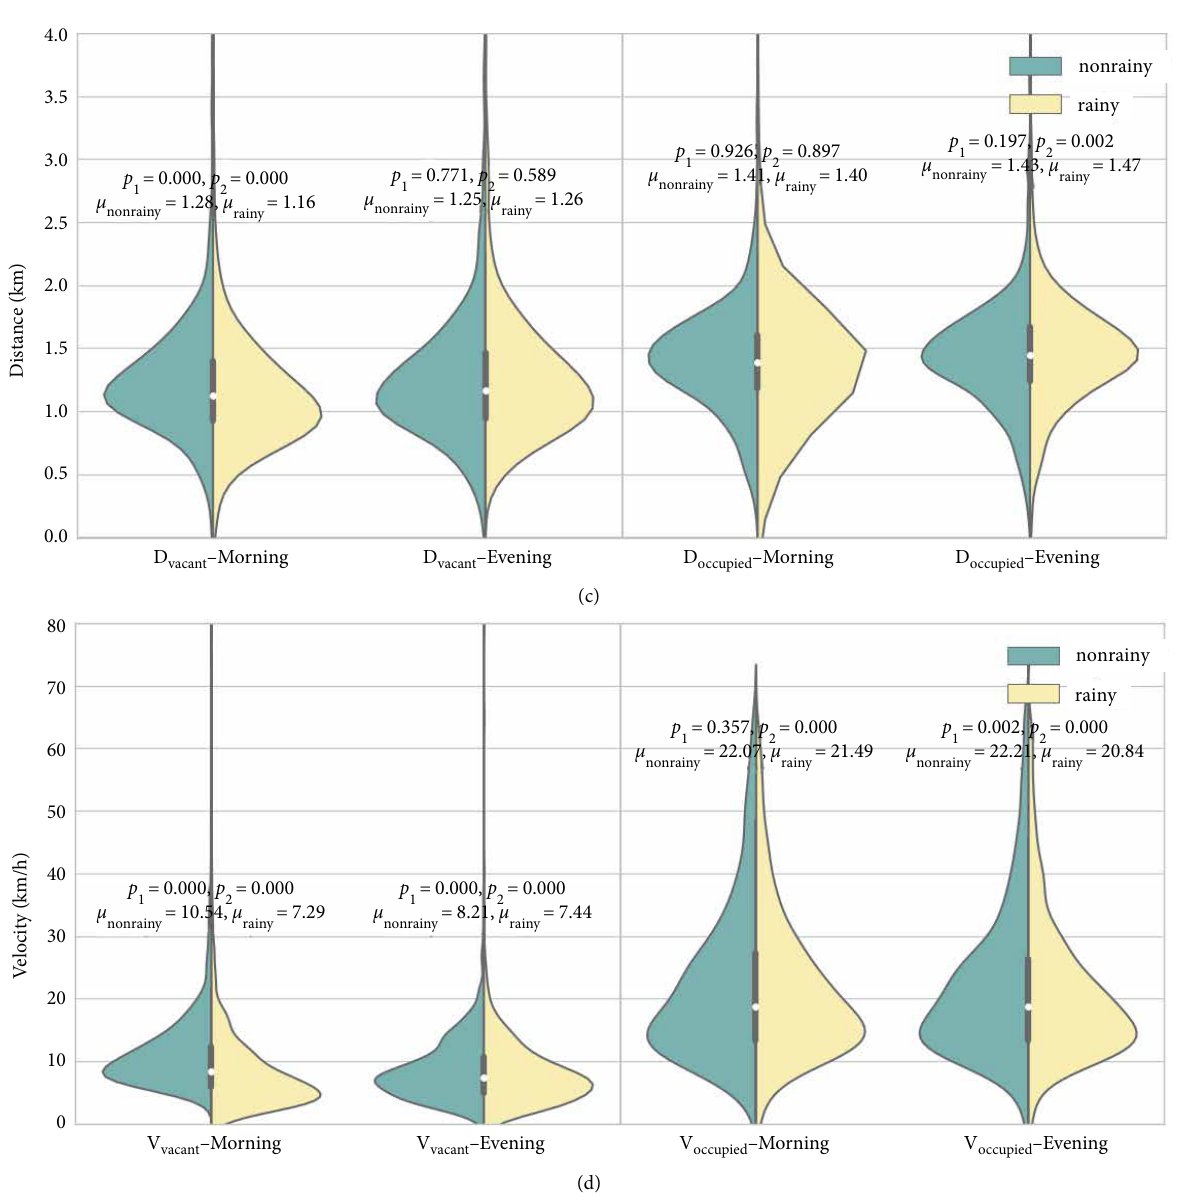
Figure 5: Data structures and test results of each factor on rainy and nonrainy days. (a) Data distribution of 𝑁 passenger and 𝑁 taxi . (b) Data distribution of 𝑇 vacant and 𝑇 occupied . (c) Data distribution of 𝐷 vacant and 𝐷 occupied . (d) Data distribution of 𝑉 vacant and 𝑉 occupied